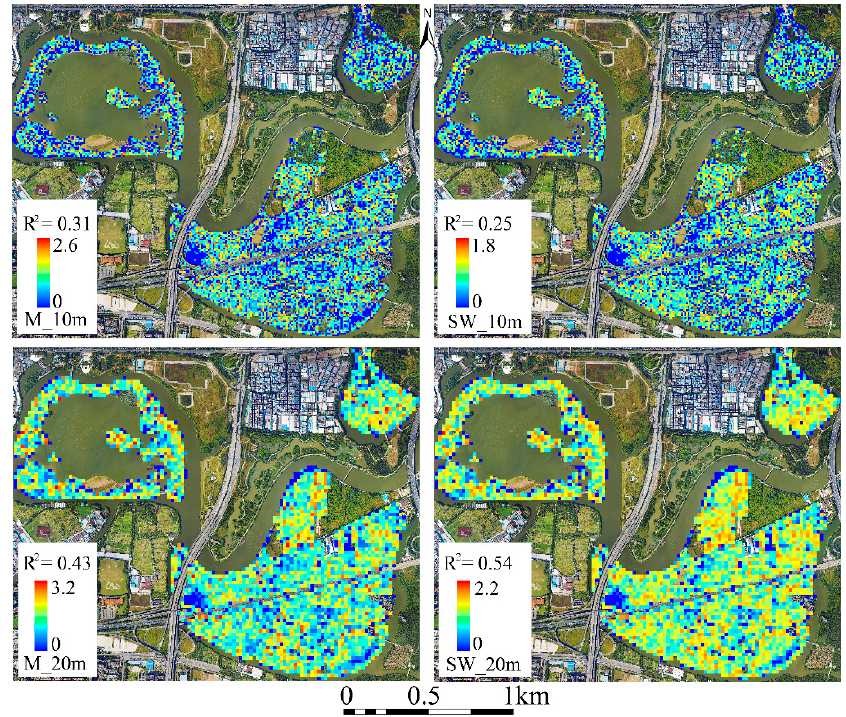
Figure 7. Tree species diversity maps at the spatial resolutions of 10 and 20 m. M_10m and M_20m represent the Margalef index at 10 and 20 m scales, respectively. SW_10m and SW_20m are for the Shannon–Wiener index at 10 and 20 m scales, respectively.